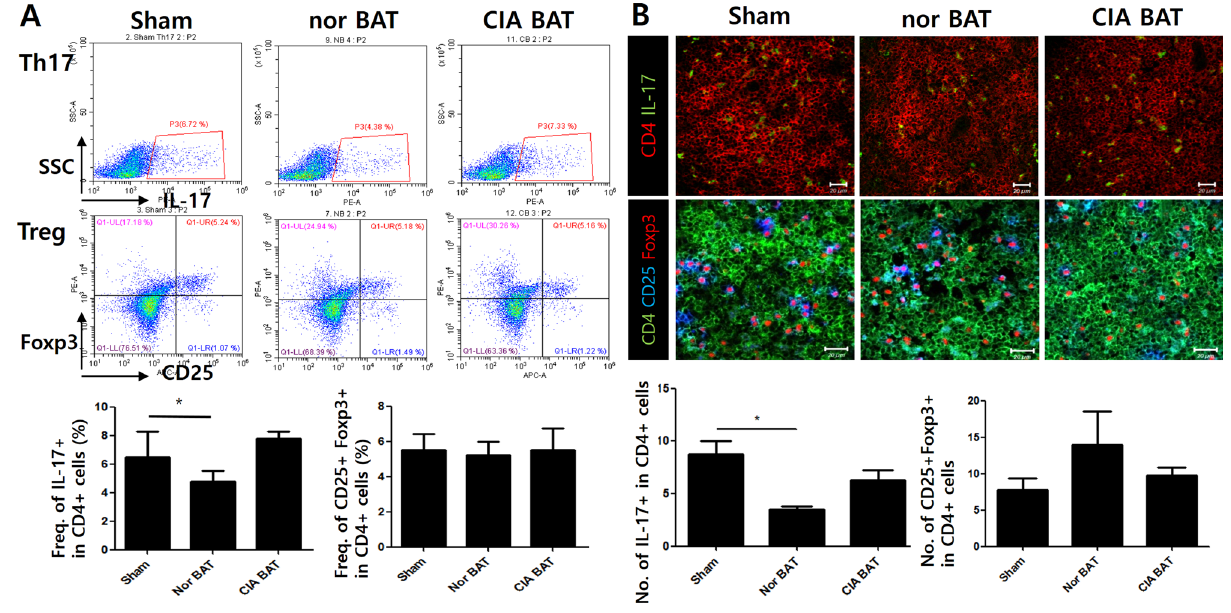
Figure 3. Populations of Th17 and Treg cells were reduced by transplantation of normal BAT in CIA mice. ( A ) Numbers of Th17 and Treg cells were measured by ex vivo FACS in the splenocytes of control and adipocyte tissue-transplanted mice. ( B ) Splenic tissue from each group of mice was monitored by immunofluorescence staining. *P < 0.05. Scale bars = 20